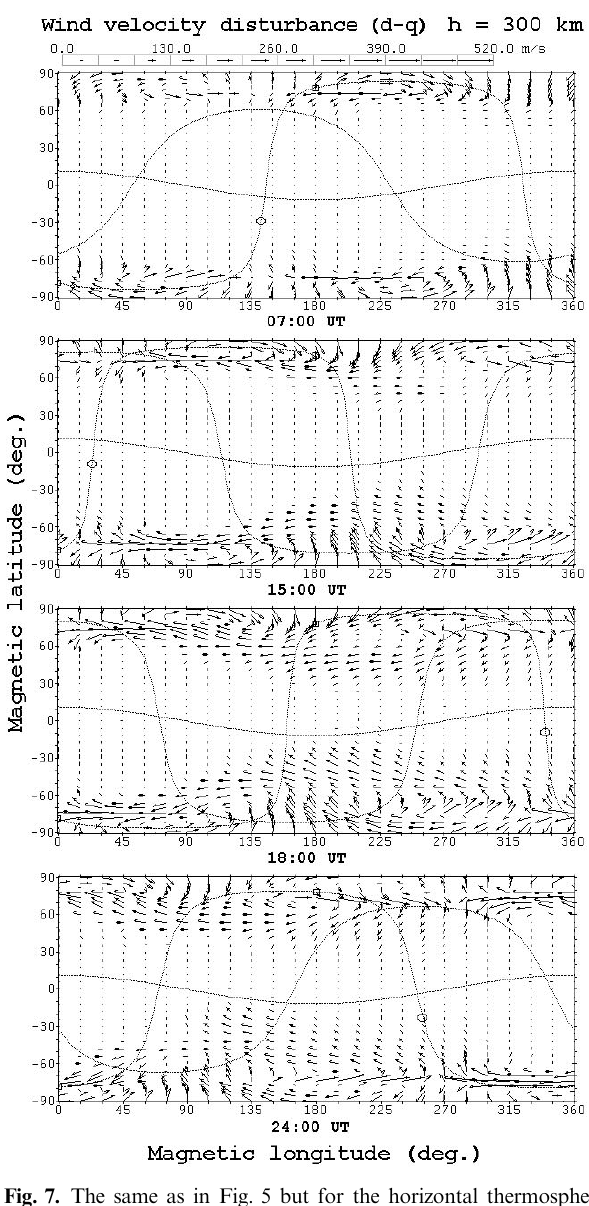
Fig. 7. The same as in Fig. 5 but for the horizontal thermospheric wind disturbance (storm minus quiet velocity, m s )